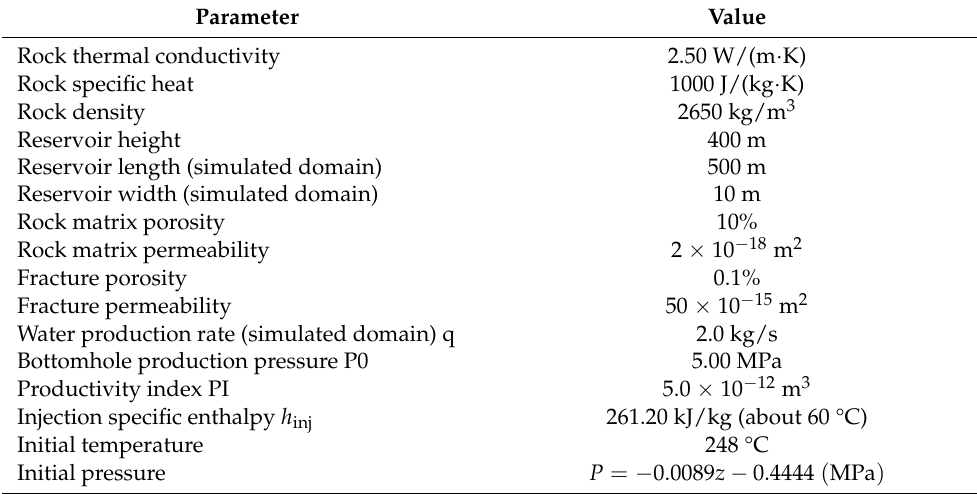
Table 1. The 950–1350 m reservoir properties and conditions at well ZK4001 [30].